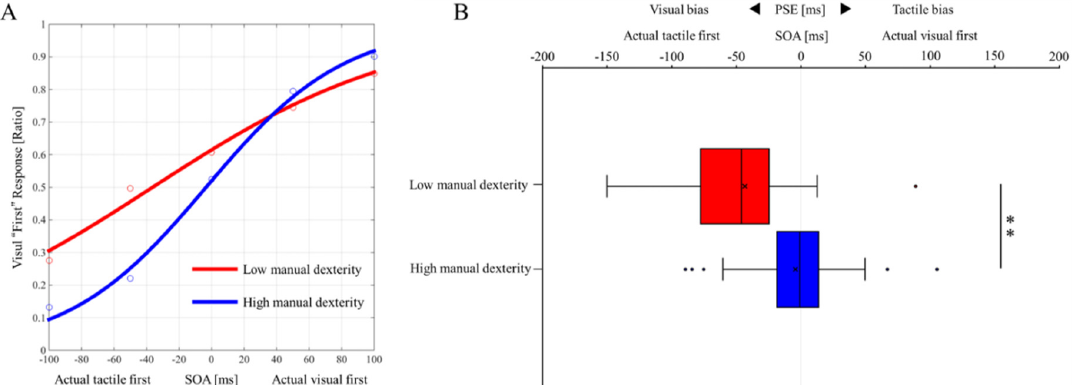
Figure 3. The probability curve of the “visual first” response in each group and the inter-group comparison results of perceptual biases. ( A ) The "visual first" response probability curves of each group in the TOJ task. Blue, high manual dexterity children group ( n = 71, mean ± standard deviation, − 4.3 ± 33.8). Red, low manual dexterity children group ( n = 29, mean ± standard deviation, − 43.4 ± 44.0). ( B ) The comparison results of perceptual biases (PSE) between groups. Blue box, high manual dexterity children group ( n = 71). Red box, low manual dexterity children group ( n = 29). Lines represent the range of the minimum (left end) and maximum (right end). Boxes represent the lower (left end), median (center line), and upper (right end) quartiles. Low manual dexterity children group: maximum = 88.84, upper quartile = − 24.72, median quartile = − 45.87, lower quartile = − 76.54, minimum = − 150. High manual dexterity children group: maximum = 105.4, upper quartile = 13.22, median quartile = − 1.004, lower quartile = − 16.25, minimum = − 89.47. ** P < 0.01; * P < 0.05. TOJ, temporal order judgement; PSE, point of subjective equality; SOA, several stimulus onset asynchronies.